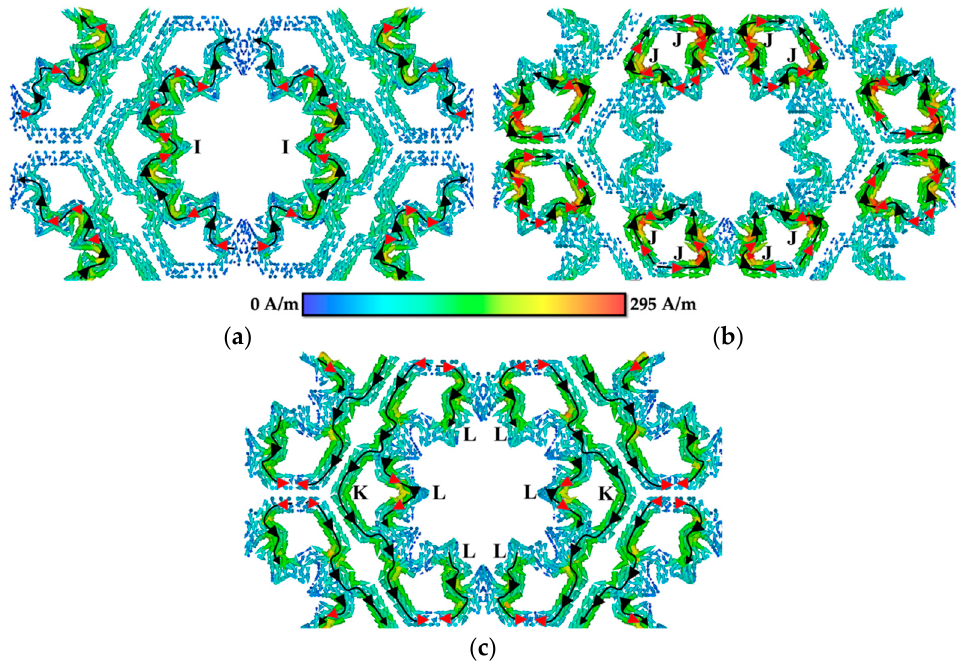
Figure 10. Surface current distribution of opaque MFSS at ( a ) 9.94 GHz, ( b ) 32.46 GHz, and ( c ) 35.41 GHz.